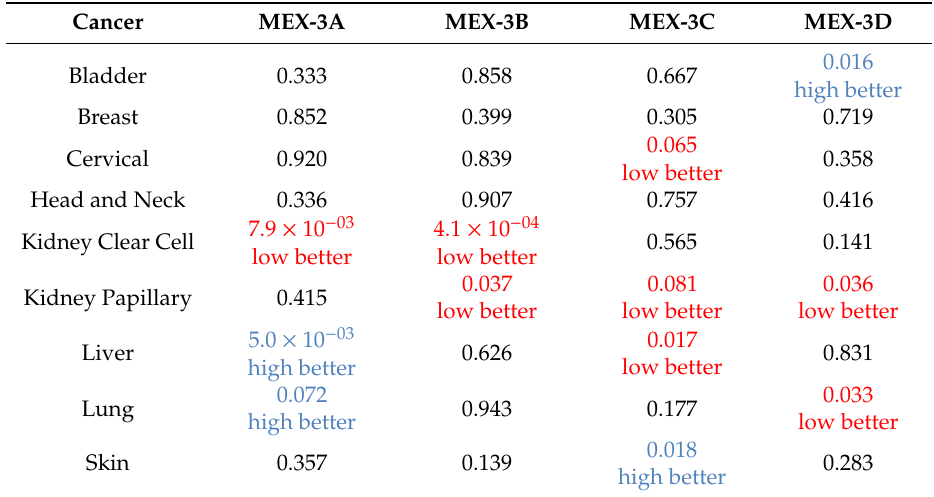
Table 2. Influence of MEX-3 homologs on the overall survival (OS) of cancer patients.